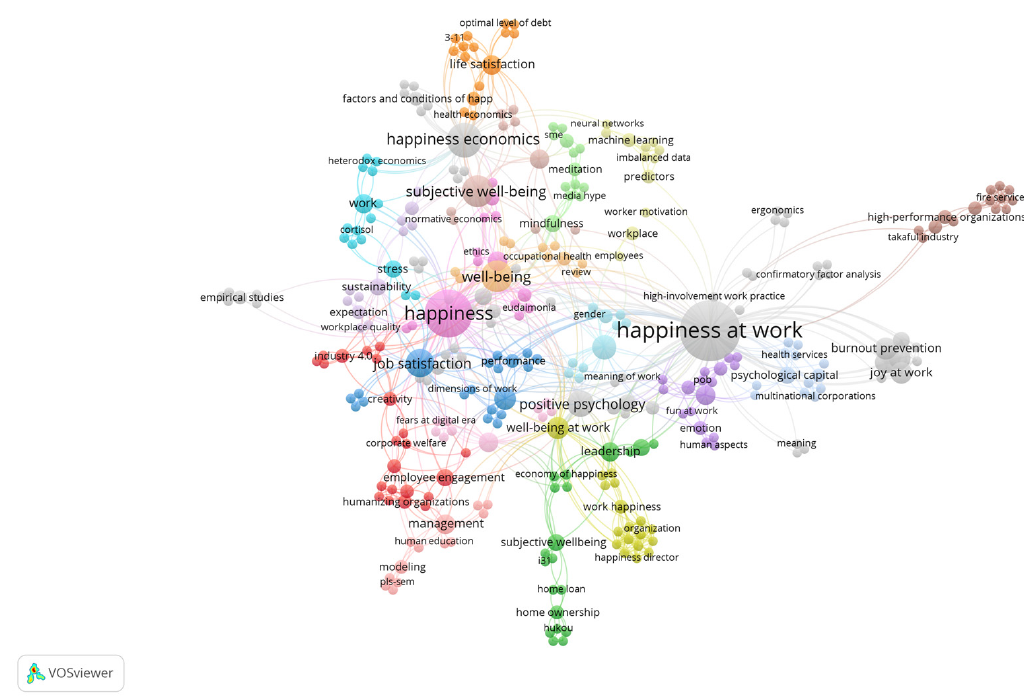
Figure 6. Keyword co-occurrence maps; period: 2015–2020.